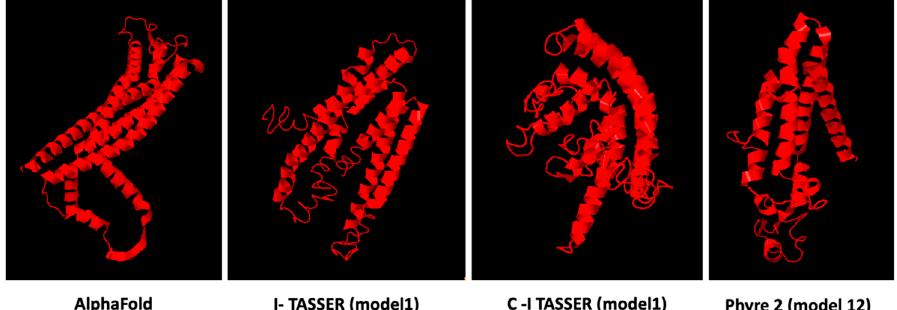
Figure 3. Protein structure prediction models of PLP1 calculated by different computational method- ologies. AlphaFold model presented high confidence for the residue of the protein at position 31 (pLDDT > 90), but limited confidence for the PLP1 residue at position 137 (pLDDT < 50). Model 1 showed the highest C- score ( − 3.95) in I-TASSER and C-I-Tasser ( − 3.89) servers. Phyre2 model 12 with a confidence of 16.98% was the only one that included the residues analyzed in this study.